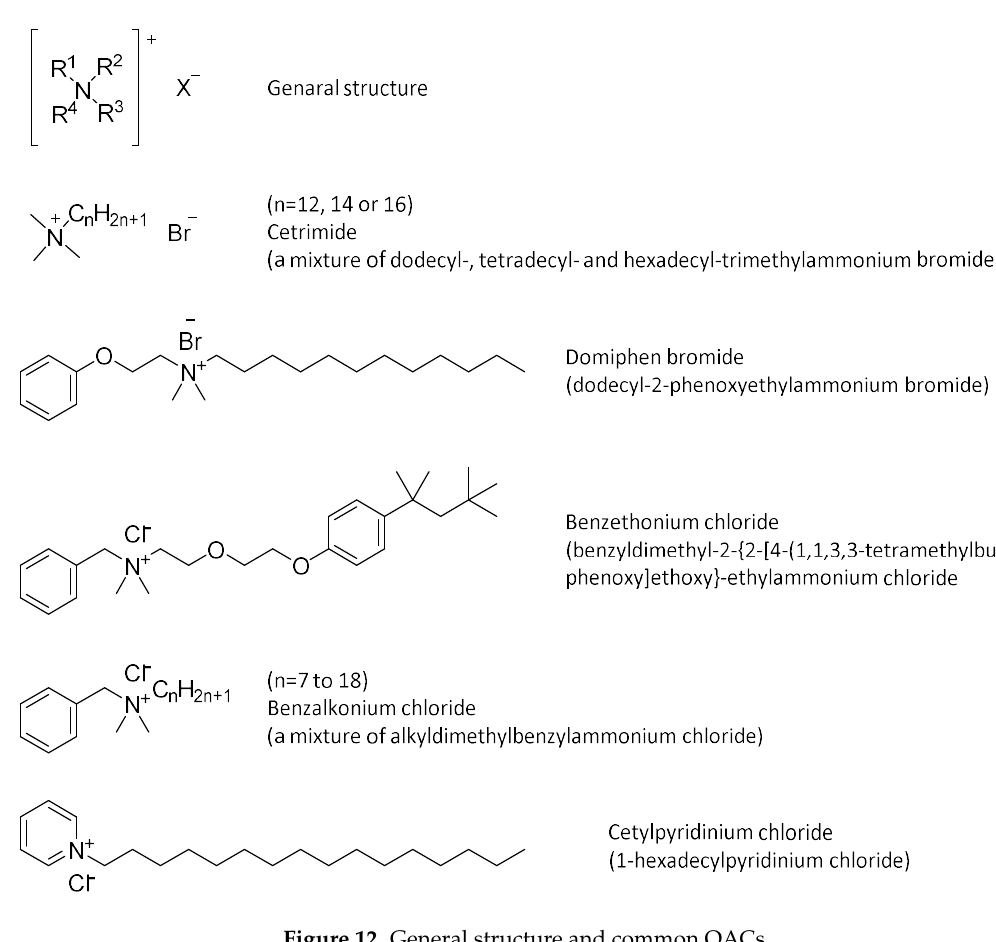
Figure 12. General structure and common QACs.